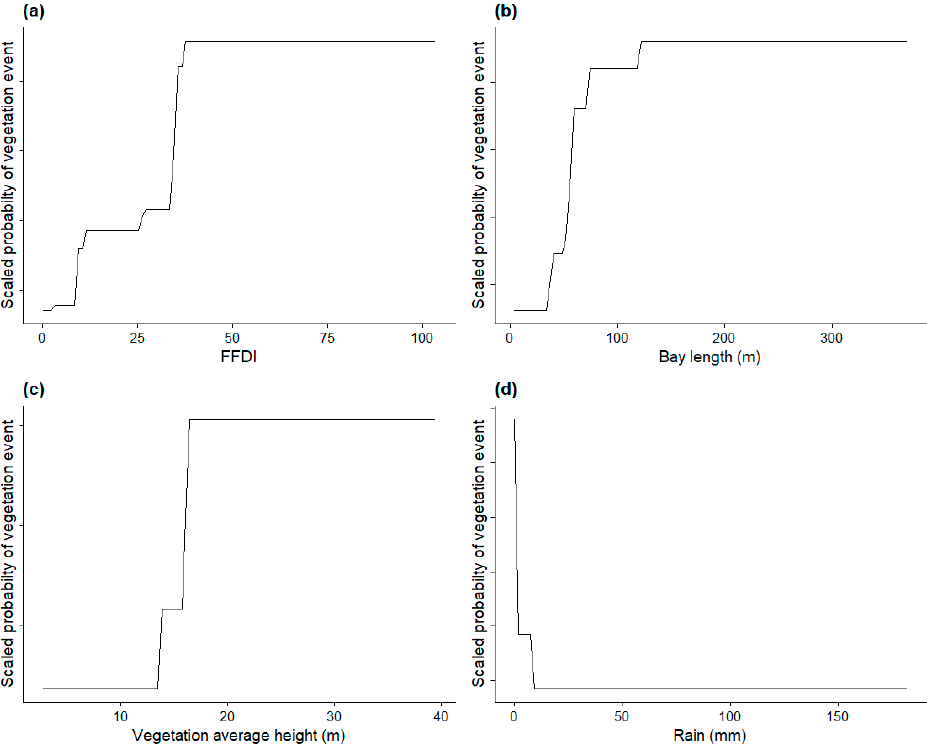
Figure 3. Marginal effect plots for ( a ) FFDI; ( b ) bay length; ( c ) vegetation average height; and ( d ) daily rainfall for the ignition event model. These are the top 4 influential variables (excluding categorical variables) in the ignition event model. The black line shows the relationship between the probability of a vegetation incident and the input variable averaging over all other input variables in the model. The y axis is the probability scaled by the logistic function and is calculated prior to the rare event correction. The sub-plots are not directly comparable; however, their relative influence can be obtained from Table 3.